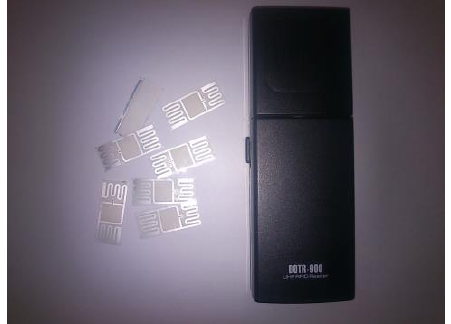
Figure 2. DOTR-900 UHF RFID reader & tags